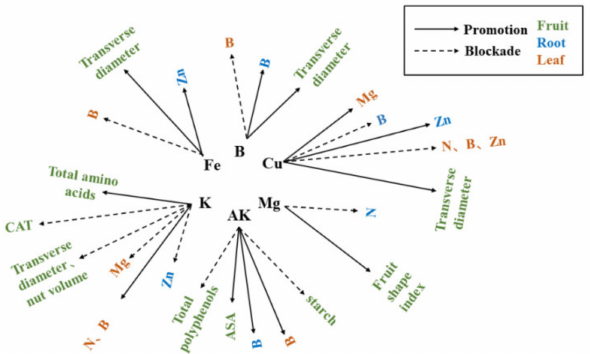
Figure 7. An action model of the altered soil elements on root elements, leaf elements, and nut